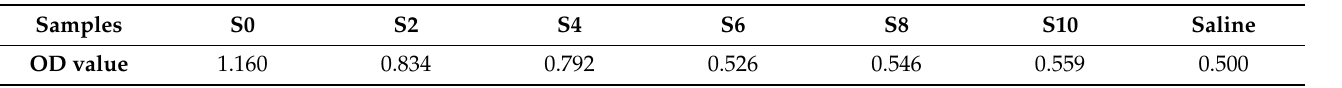
Figure 7. Bacterial adhesion morphologies of MAO coating with different CuSO 4 additions of ( a ) 0, ( b ) 2, ( c ) 4, ( d ) 6, ( e ) 8, and ( f ) 10 g/L. Table 1. OD values of CuSO 4 specimens added at different concentrations in a constant temperature shaker for 3 days.